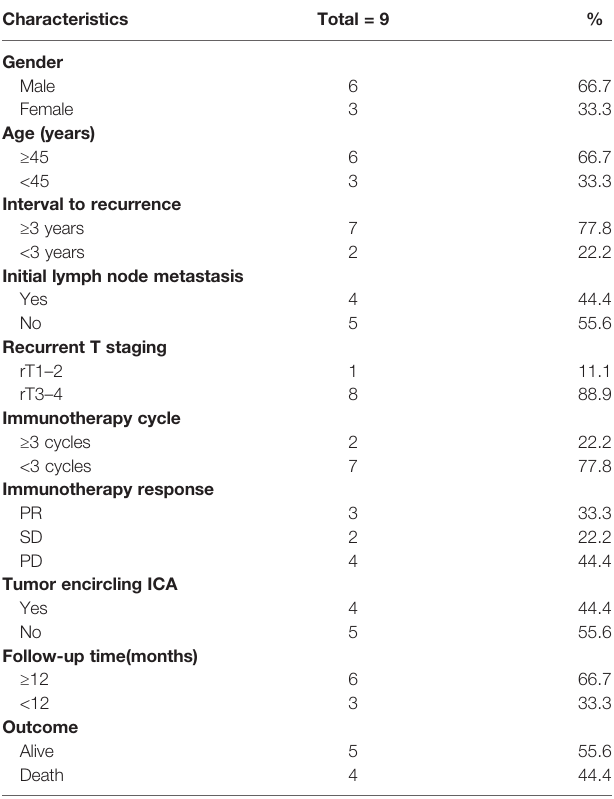
TABLE 1 | Demographics and clinical characteristics of patients with recurrent NPC in this study.